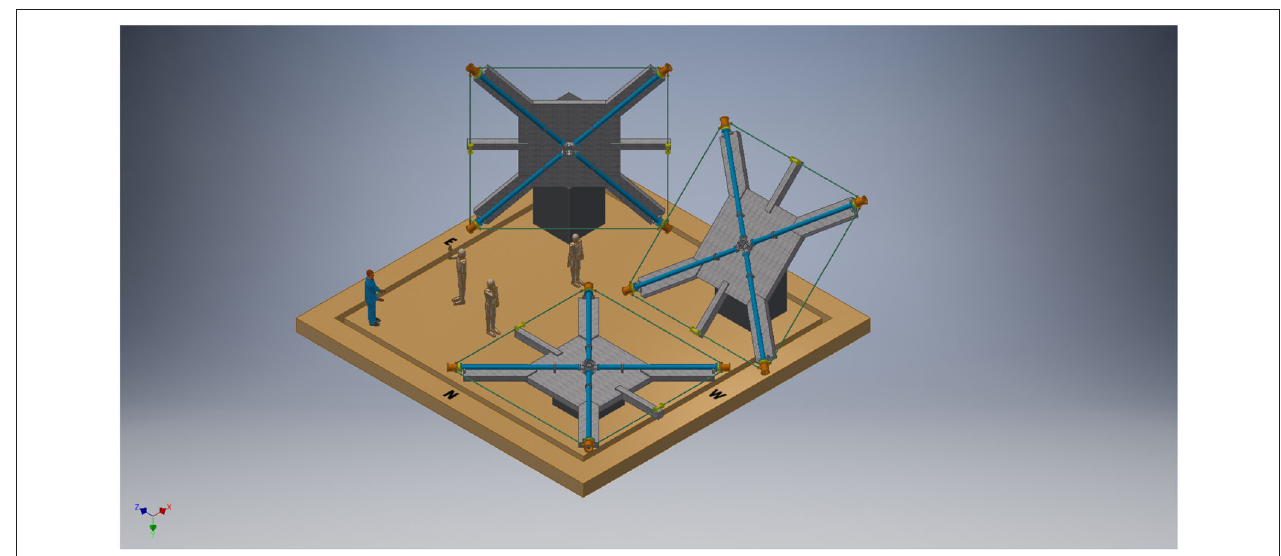
FIGURE 3 | Pictorial view of GINGER, the three RLG are separated one from the other, and the details of the mechanical arrangement are